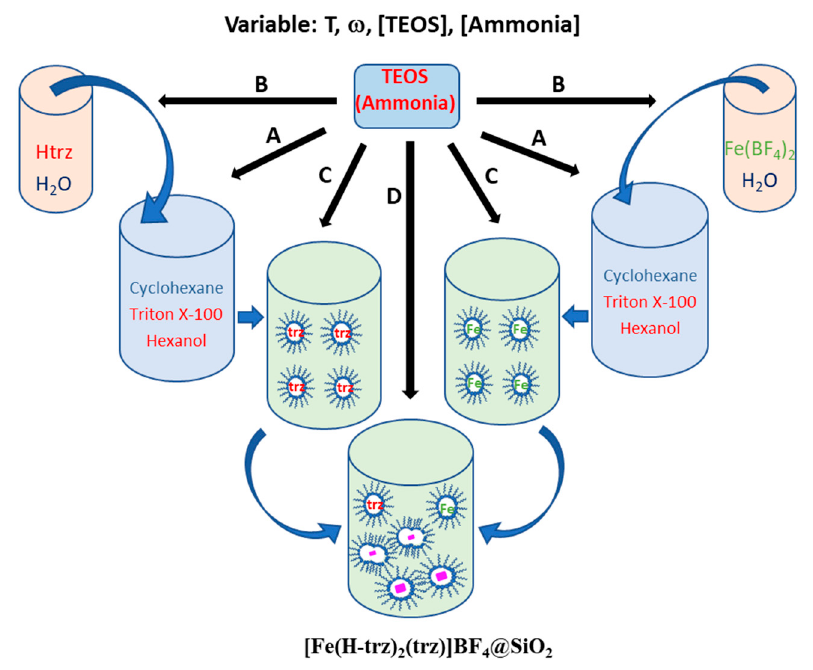
Scheme 1. Schematic representation of the synthetic routes A–D and changing experimental eters.